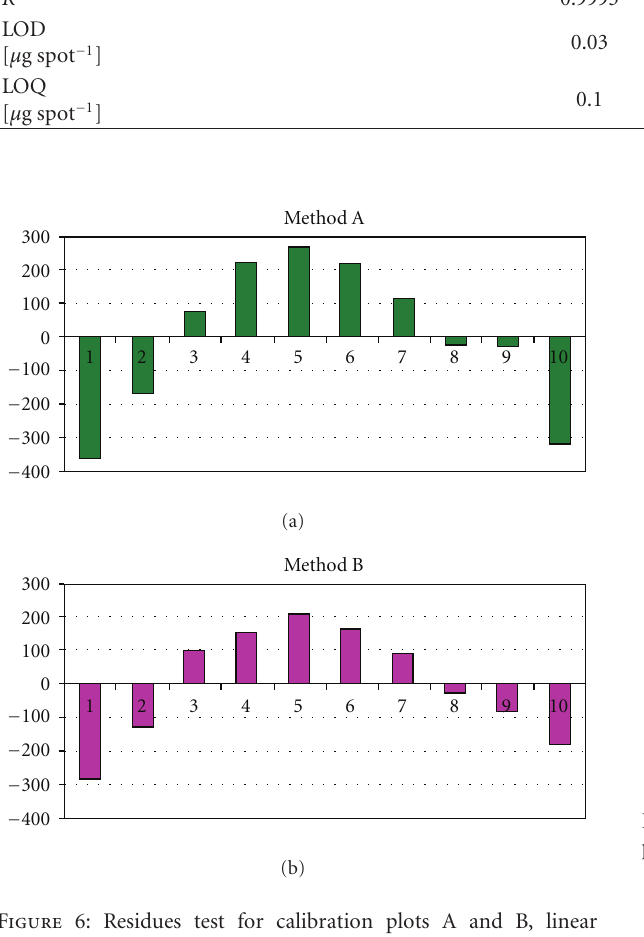
Figure 6: Residues test for calibration plots A and B, linear regression. Method A: y = 2341 . 5 x + 874 . 84, R = 0 . 9905. Method B: y = 1409 . 5 x + 763 . 97, R = 0 . 9851.